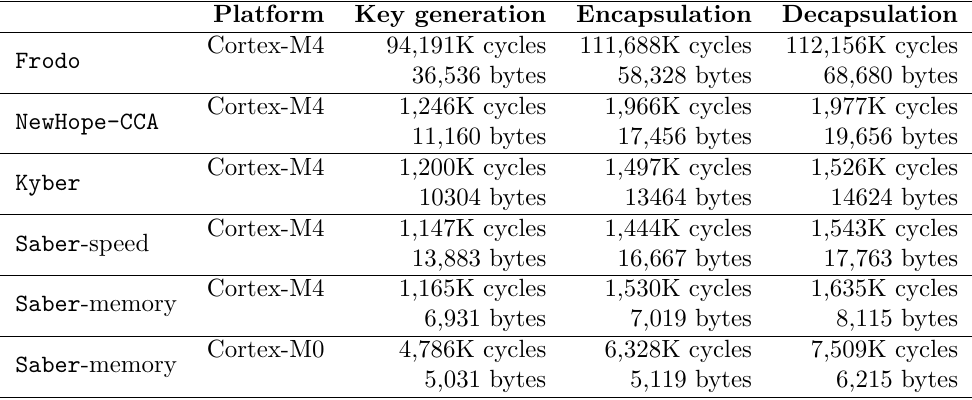
Table 3: Comparisons with other reported implementations of lattice-based schemes in ARM Cortex-M microcontrollers in terms of of time and memory